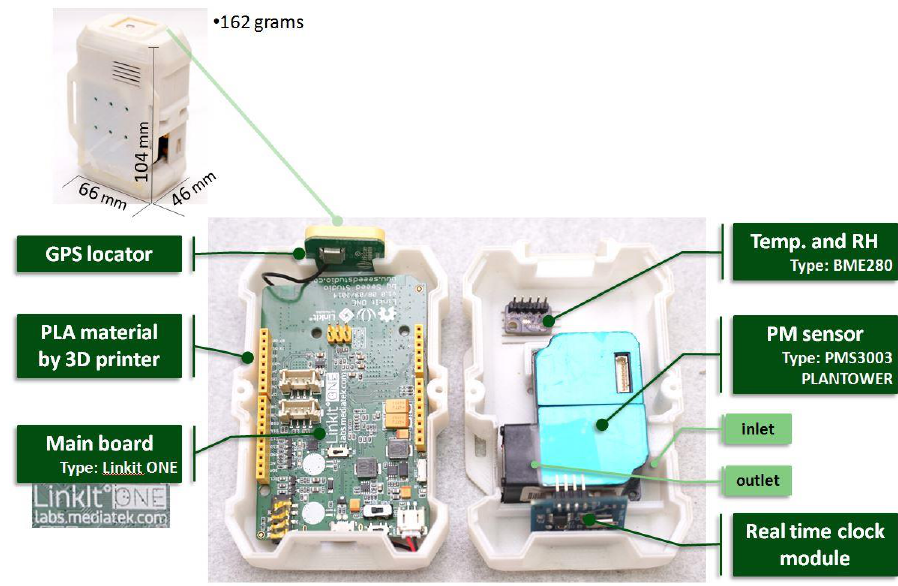
Figure 1. Low-cost particulate matter (PM) sensing device, Location-Aware Sensing System (LASS), used in this work; various components and the inlet/outlet of LASS are marked; sensor components and the real-time clock modules are connected to the mainboard with wires not shown in the figure to avoid blocking views of the board. PLA: polylactic acid, a material commonly used for 3D printing.